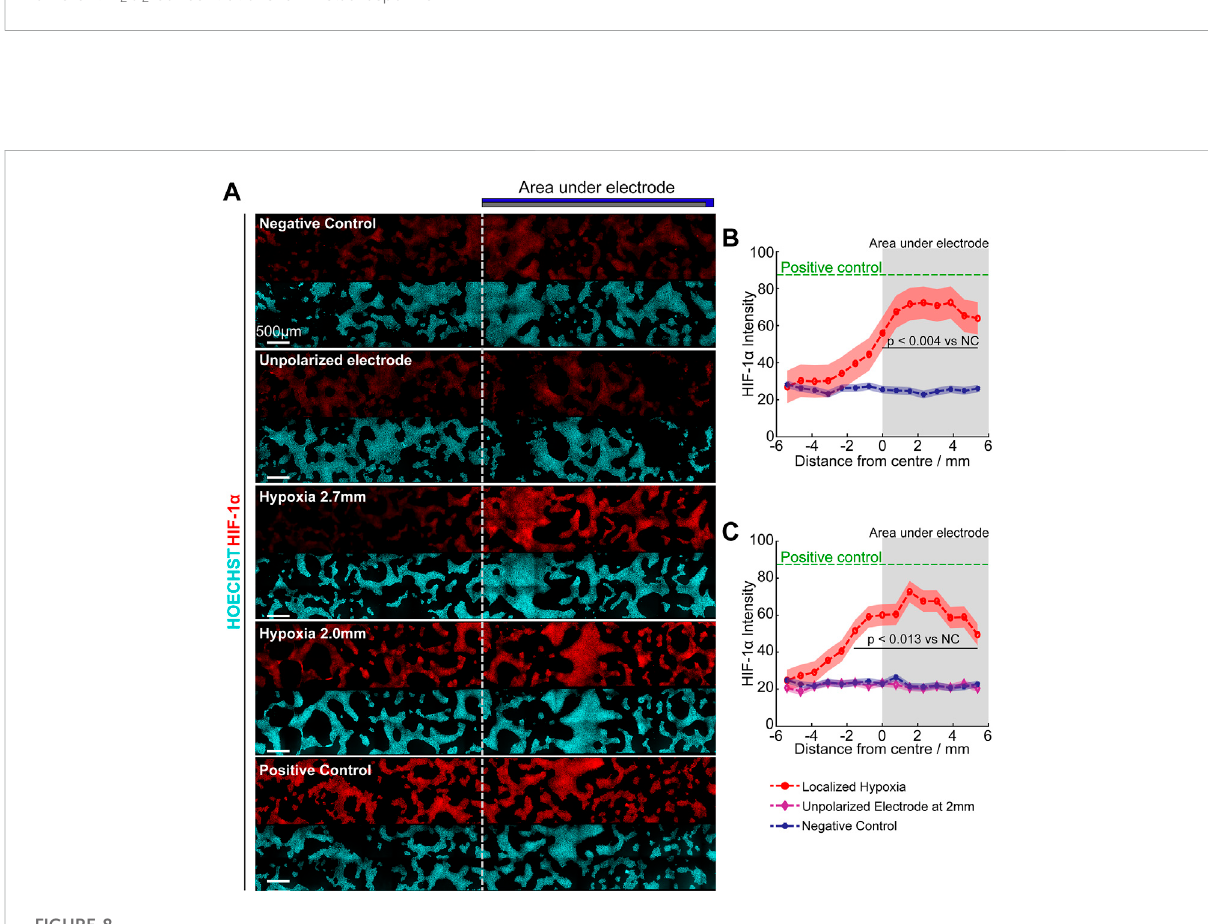
FIGURE 8 Focal hypoxia in a well. (A) Confocal images of cultures under different hypoxia conditions. Dotted line indicates the border of the electrode. (B,C) Quantitative analysis of mean HIF-1 α intensity (curve) ± standard deviation (shaded region) across the base under 2.7 mm (B) and 2.0 mm (C) height of scavenging electrode, analysed with Tukey multiple comparison. Green: Positive control (250 µM DMOG); Red: Scavenging electrode polarized; Purple: Scavenging electrode unpolarized; Blue: Negative control. Grey shaded area indicates regions under oxygen scavenging